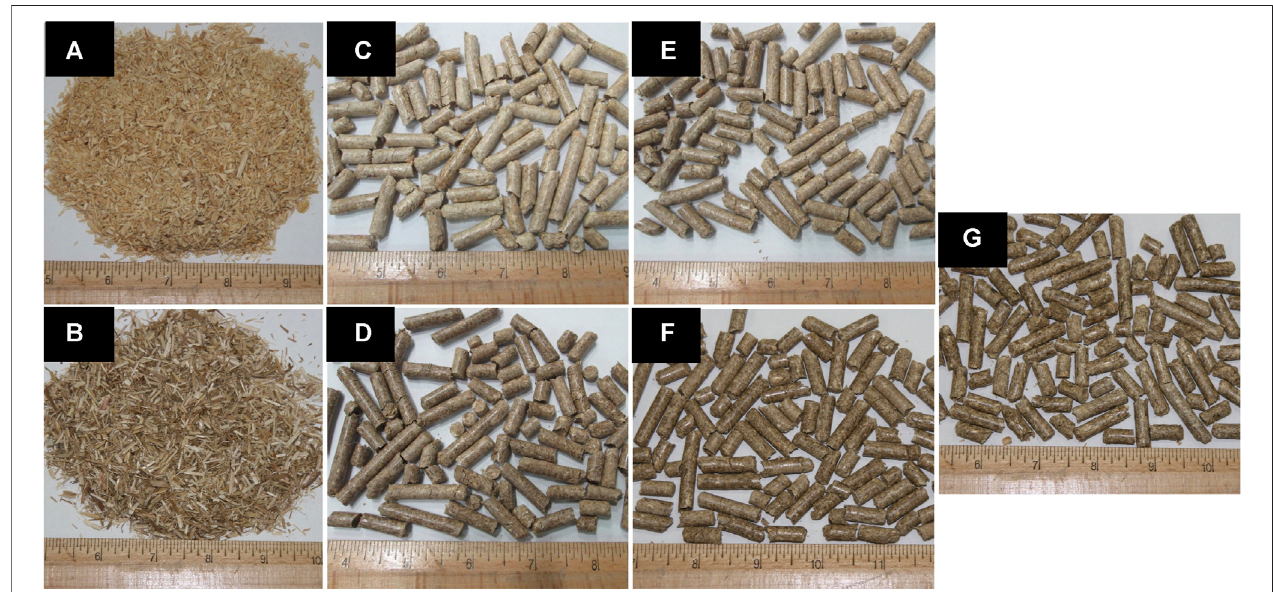
FIGURE 2 | Raw biomass and pellets made of 6-in. (152.4 mm) southern yellow pine (SYP) tops, switchgrass (SG), and their blends. All pellets were produced at high-moisture content (20% w.b.) and at two different length-to-diameter ratios (7 or 9). (A) SYP tops ground to 6.35 mm screen size in a hammer mill; (B) SG biomass groundto6.35 mm screensize inahammer mill; (C) 100%SYPpellets; (D) 100% SGpellets; (E) 75% SYPand 25%SGpellets; (F) 75%SG and25% SYPpellets; and (G) 50% SYP and 50% SG pellets.